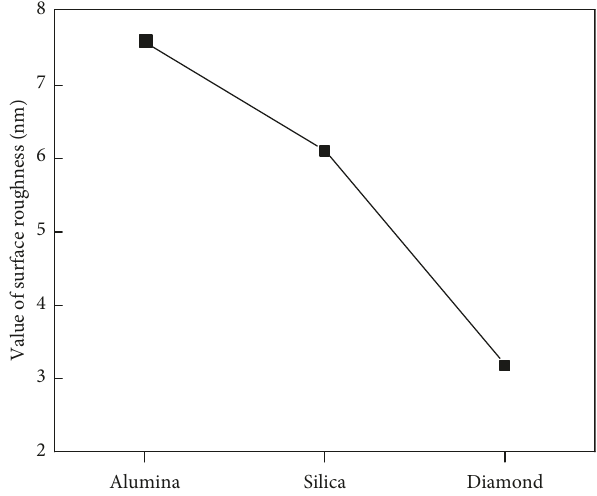
Figure 2: The relationship between the surface roughness and the type of polishing solution.